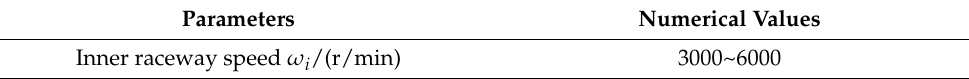
Table 2. Parameters for numerical solution of contact forces for rotational speed